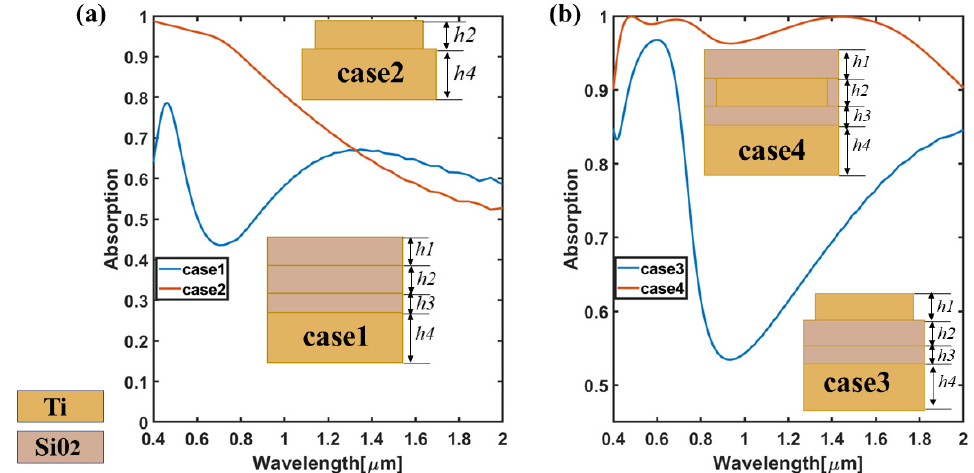
Figure 4. Absorption efficiency diagram under various cases . ( a ) The absorption efficiency diagram corresponding to case1 and case2; ( b ) The absorption efficiency diagram corresponding to case3 and case4.